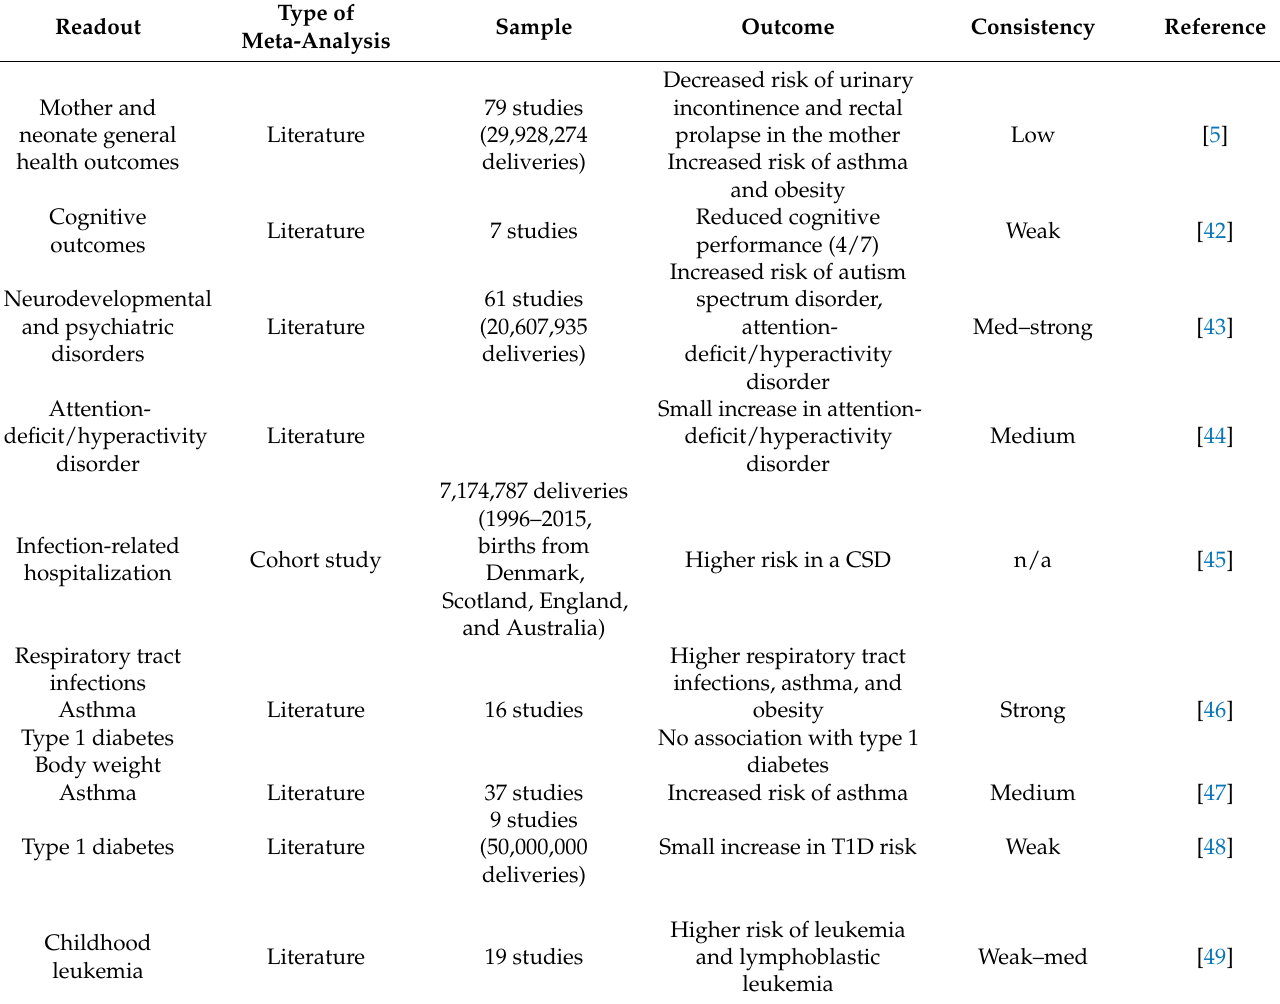
Table 1. Systematic reviews and meta-analysis addressing the risk of disease development associated with CSD in the last 5